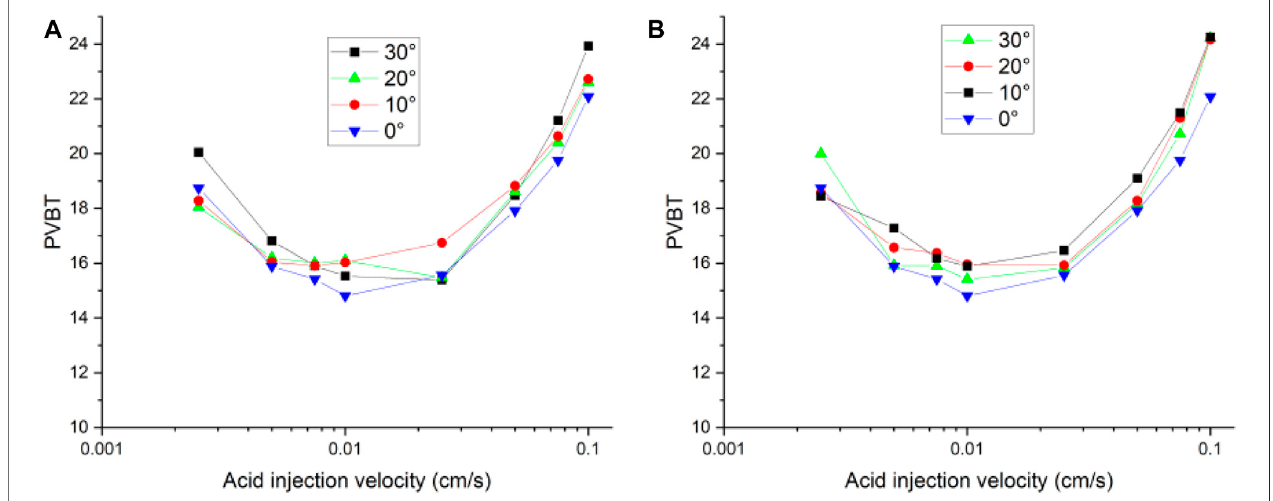
FIGURE 11 | Isolated fracture acidizing curves of pore volume to breakthrough with different angles: (A) clockwise; (B) anticlockwise.